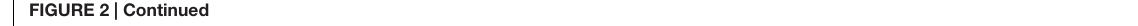
24 hpi: 6.19 ± 2.24), suggesting an activation of JA